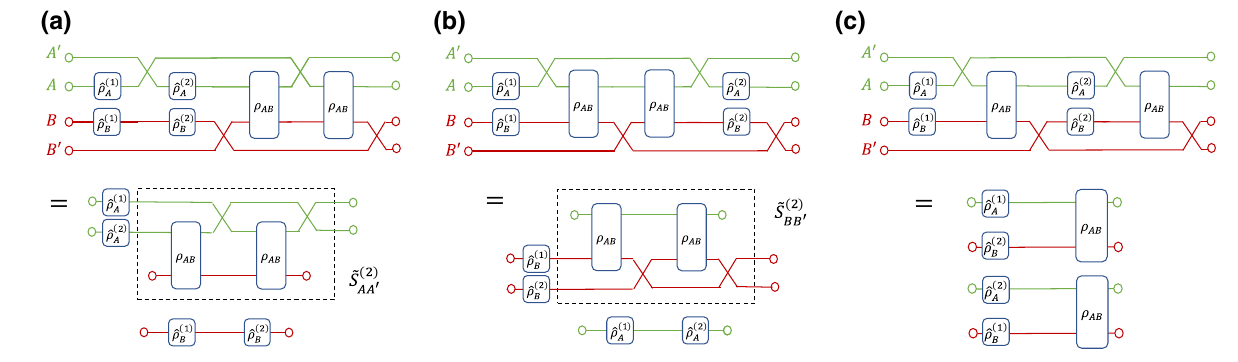
(cid:9) ˜ S ( 2 ) ) ] = Tr ( ˆ ρ ( 1 ) AB A AA (cid:13)